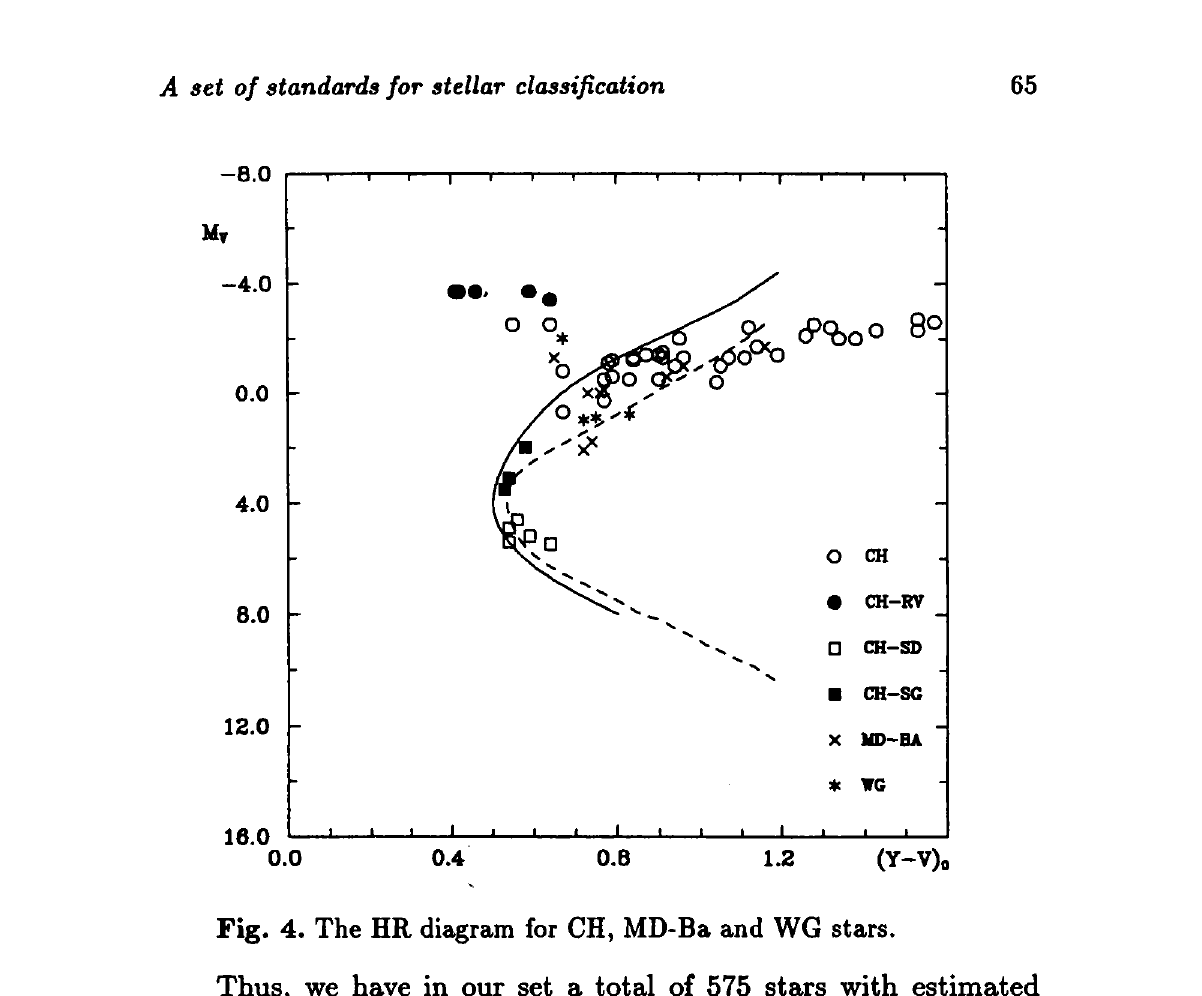
Fig. 4. The HR diagram for CH, MD-Ba and WG